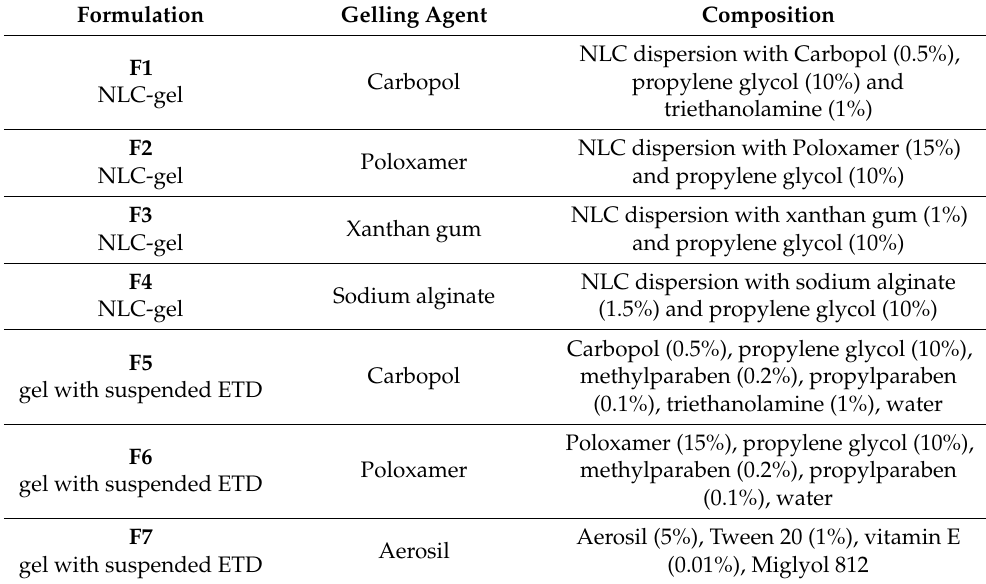
Table 7. Composition of ETD-loaded gel formulations (all gels containing ETD at concentration of